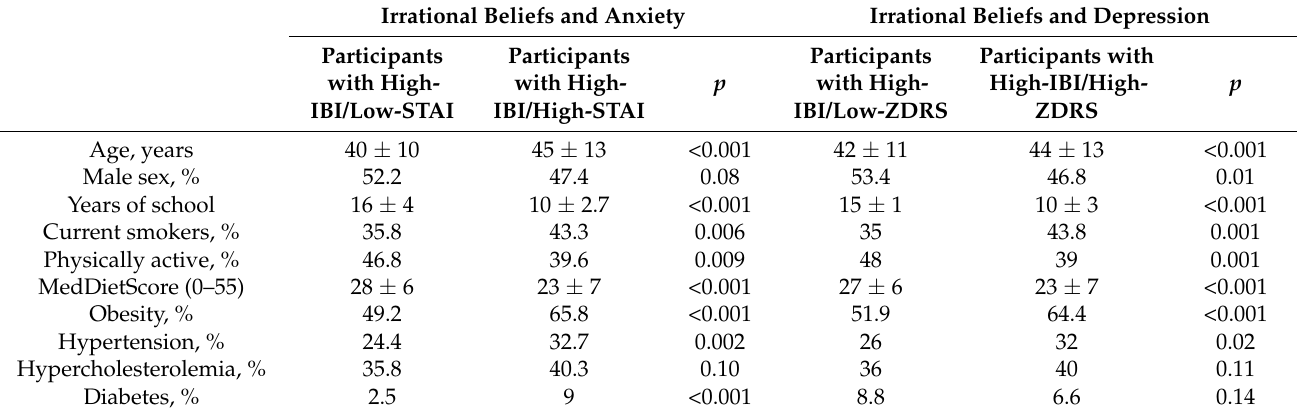
Table 1. Socio-demographic and clinical characteristics of participants with a high IBI score ( ≥ 52), who also had anxiety symptoms (i.e., STAI > 40) or depression (ZDRS > 34) ( n = 853). Irrational Beliefs and Anxiety Irrational Beliefs and